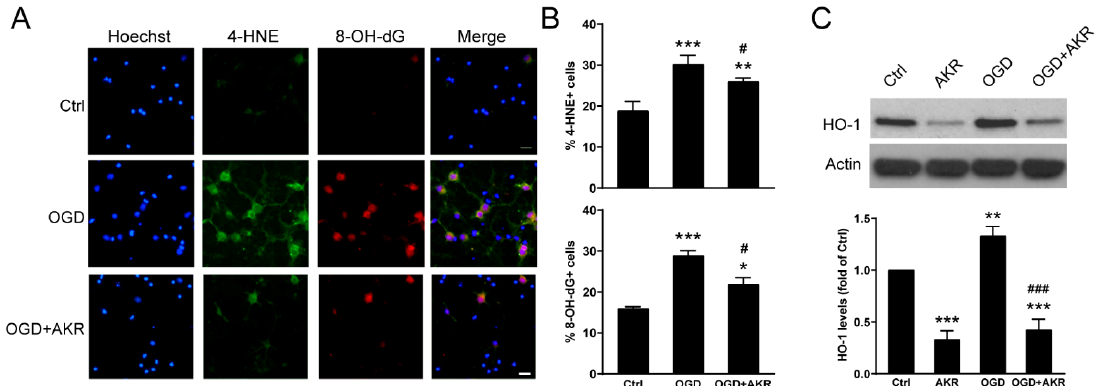
Figure 6. AKR1C15 protected against OGD-induced oxidative stress in neuronal cultures. Primary rat neurons were subjected to 1 h OGD followed by 24 h reoxygenation in the presence or absence of 10 µ g/mL TAT-AKR1C15. ( A ) Representative 4-HNE and 8-OH-dG staining and ( B ) cell counting. Scale bar: 20 µ m. ( C ) Representative Western blotting and semiquantitation for HO-1 (original Western blotting shown in Figure S1). Data are mean ± SD. n = 3–4 independent experiments. One- way ANOVA followed by Tukey’s multiple comparison. *, **, *** p < 0.05, 0.01, 0001 vs. Ctrl. #, ### p < 0.05, 0.001 vs. OGD. OGD: oxygen–glucose deprivation. 4-HNE: 4-hydroxynonenal.